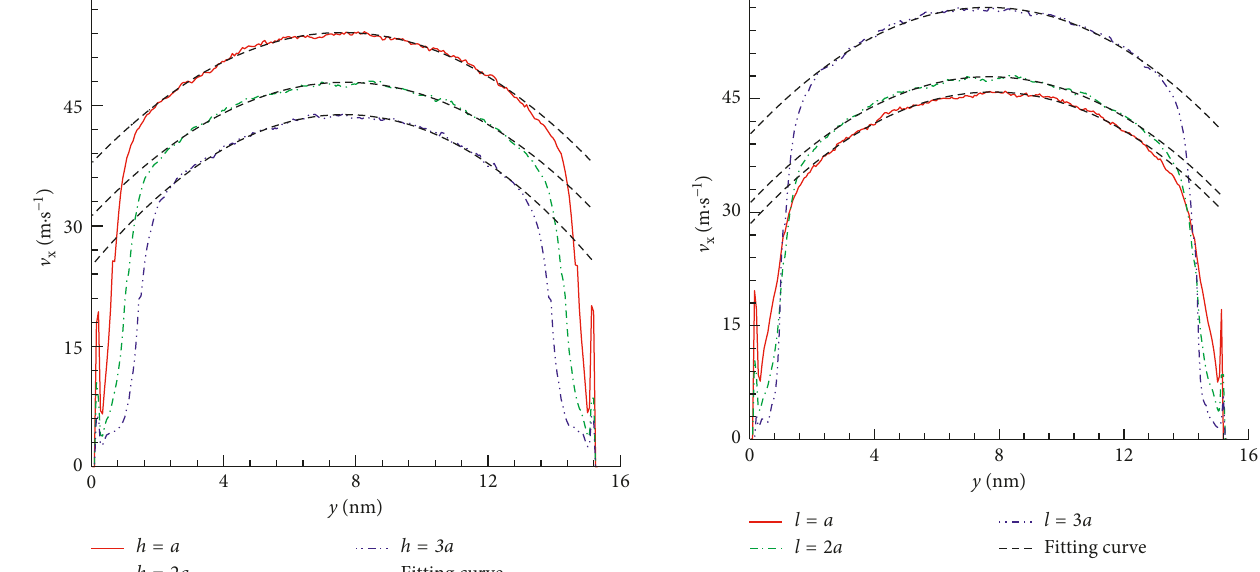
Figure 6: Velocity profiles at different roughness element